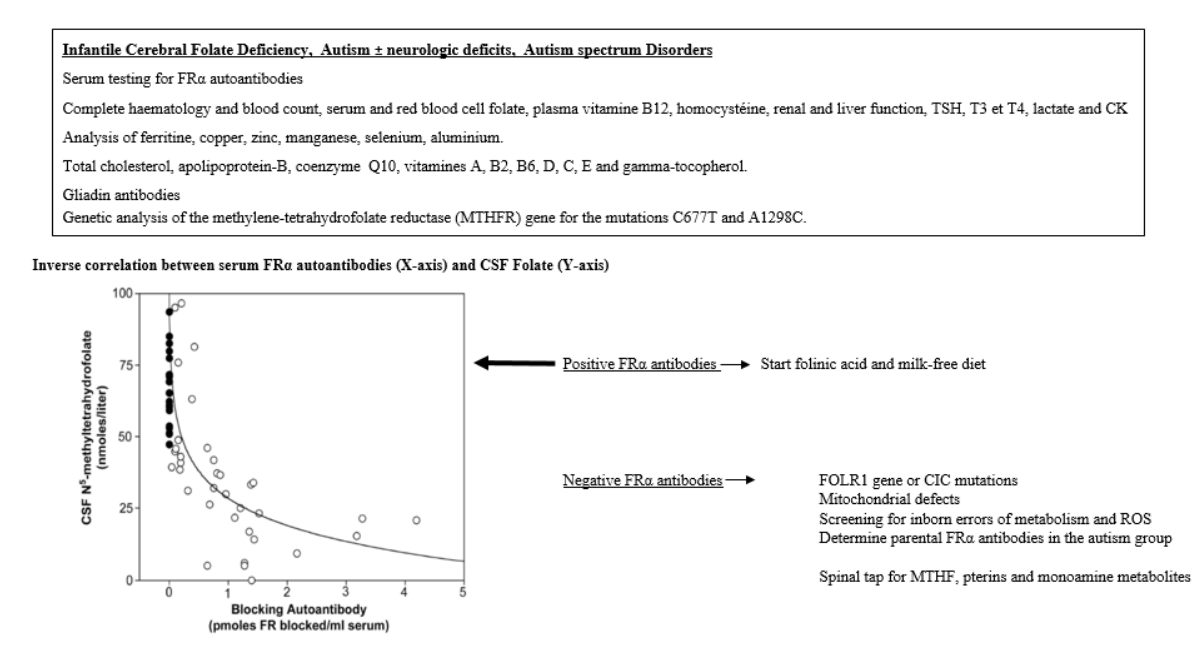
Figure 5. Diagnostic alghorhytm for infantile CFD and autistic